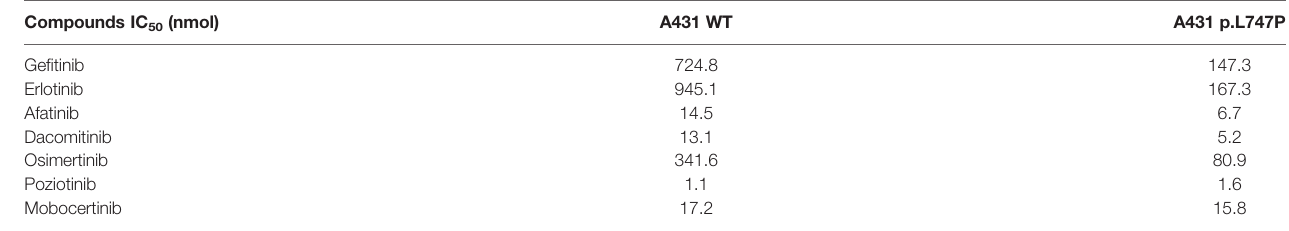
TABLE 3 | Kinase inhibition activity of diverse EGFR TKIs against p.L747P and EGFR WT cell lines. Compounds IC 50